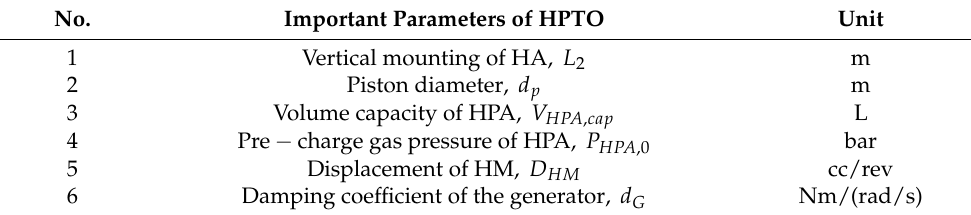
Table 1. Important parameters of the HPTO